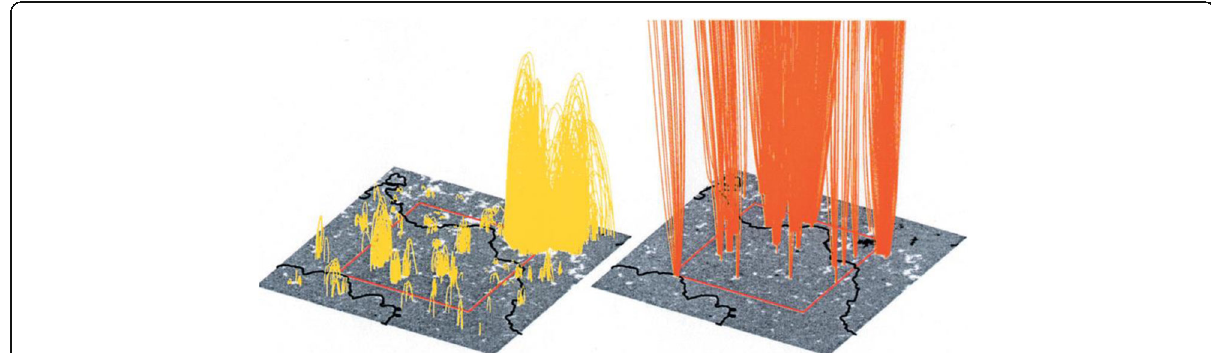
Fig. 36 Magnetic structures in a CH. The gray-coding shows the field strength in the photosphere. The black line gives roughly the boundary of the CH. The field of view for SUMER is marked as a red rectangle in both panels. The magnetic field was constructed from a MDI magnetogram. Left figure: mostly closed loops at various scales. Only closed magnetic field lines with B ≥ 30 G are shown. Right figure: only open fields with large photospheric values, B ≥ 100 G. The open flux is bundled in narrow uniform filaments and originates in stronger fields concentrated at small-scale footpoints. The flux tubes expand as they extend into the corona. Taken from Wiegelmann, Xia and Marsch (2005)